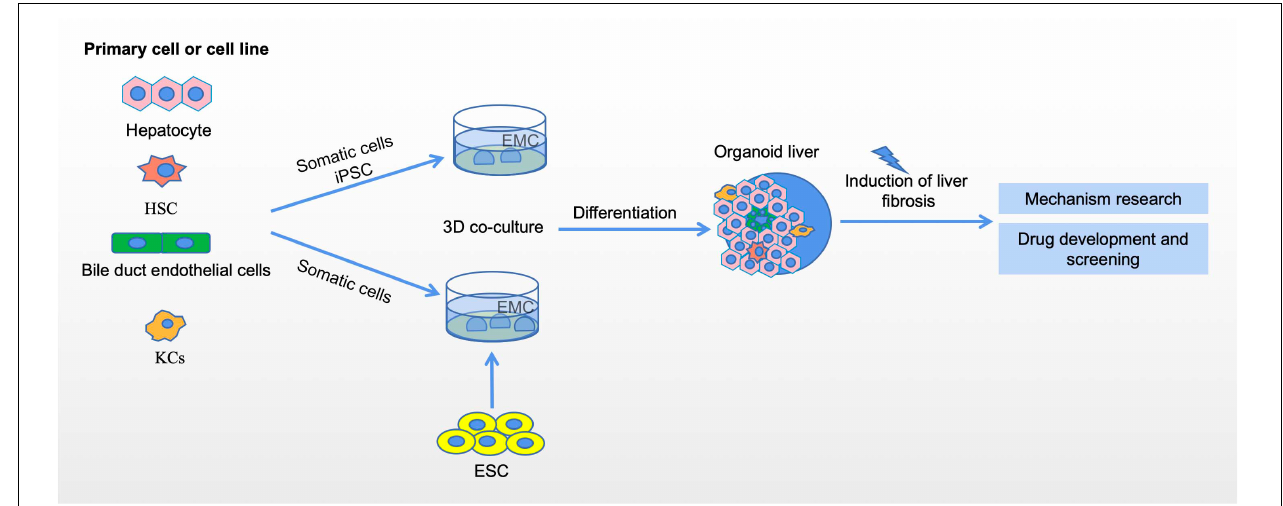
FIGURE 2 | Organoid models of liver fibrosis. The generation of liver organoids and liver fibrosis models. liver organoid can be constructed by 3D co-culture of embryonic stem cells (ESC) and somatic hepatocytes, 3D coculture of induced pluripotent stem cells, and then through induction and differentiation of different developmental stages, and finally can be developed into liver organoids in the reactor. The establishment of liver fibrosis model using liver organoids can be used to study the mechanism of liver fibrosis and drug development and